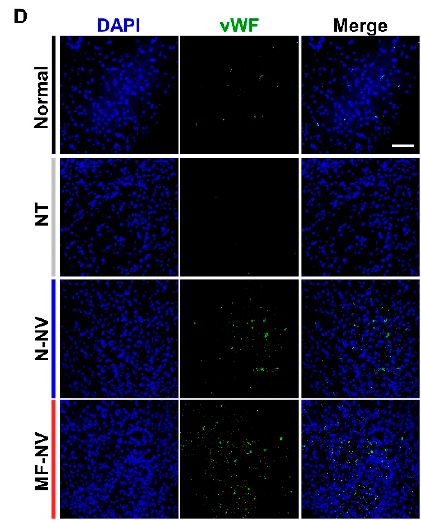
Figure 8. Enhanced neuroprotection, anti-inflammation, and angiogenesis by MF-NVs in the injured spinal cord lesion. ( A ) Representative images of terminal deoxynucleotidyl transferase dUTP nick end labeling (TUNEL) (red)-positive apoptotic cells 7 days post-injury (n = 4 animals per group). Scale bars, 20 µ m. ( B ) Representative images of immunohistochemical staining for TNF α 7 days post-injury (n = 4 animals per group). Scale bars, 20 µ m. ( C ) Relative mRNA expression levels of M1 macrophage-specific markers ( Il1b , Nos2 , and Tnfa ) and M2 macrophage-specific markers ( Il10 , Arg1 , and Vegf ) in the injured spinal cord at 3 days post-injury, as evaluated by qRT-PCR (n = 5 animals per group). * p < 0.05 by using one-way ANOVA followed by post-hoc Bonferroni test. All values are mean ± SD. ( D ) Representative images of immunohistochemical staining for blood vessels (vWF, green) at the lesion core 28 days post-injury (n = 4 animals per group). Scale bars, 20 µ m. NT indicates no treatment.